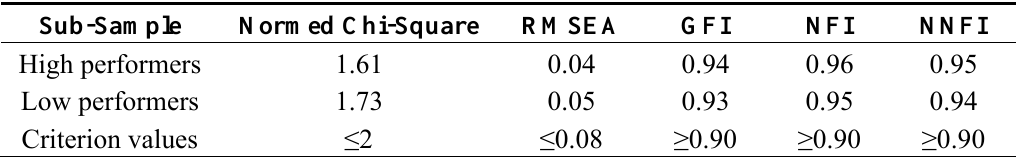
Table 3. Results of structural model goodness-of-fit indices.